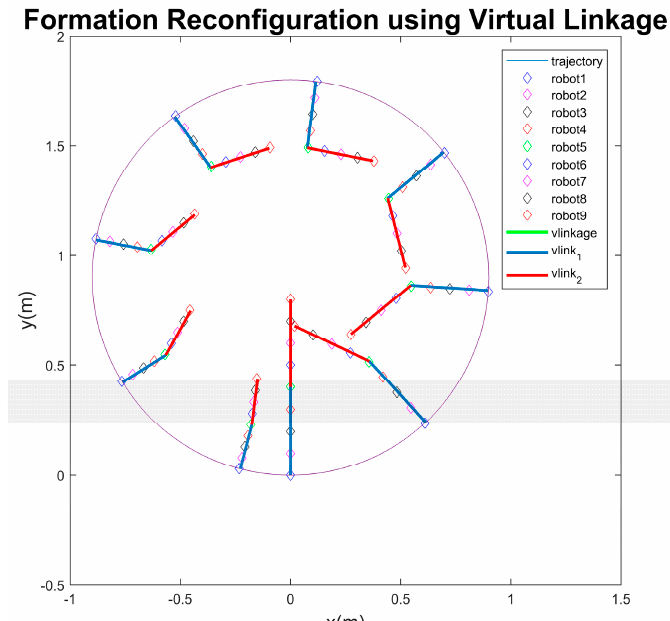
Figure 10. Snapshot of the formation reconfiguration using virtual linkage.